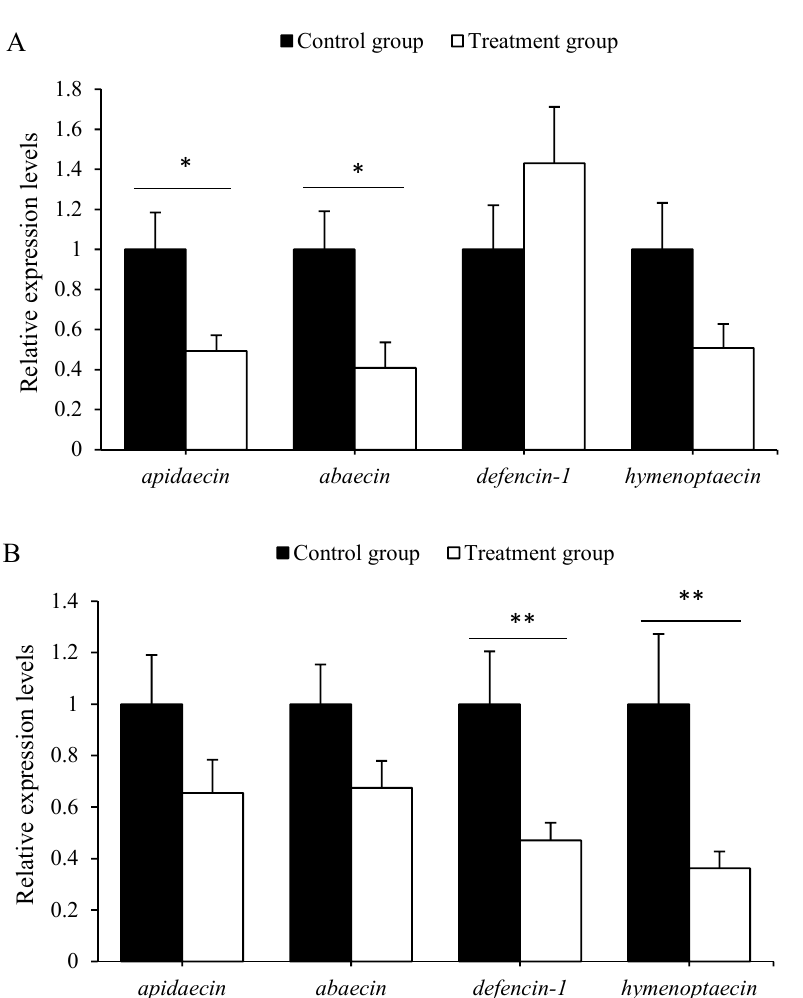
Figure 4. Antibiotics treatment effect on the expression of four innate immunity genes in 5- ( A ) and 7-day-old ( B ) A. mellifera larvae. The asterisk above the bars indicates a significant difference in gene expression level between the treatment and corresponding control (* for p < 0.05 and ** for p < 0.01).